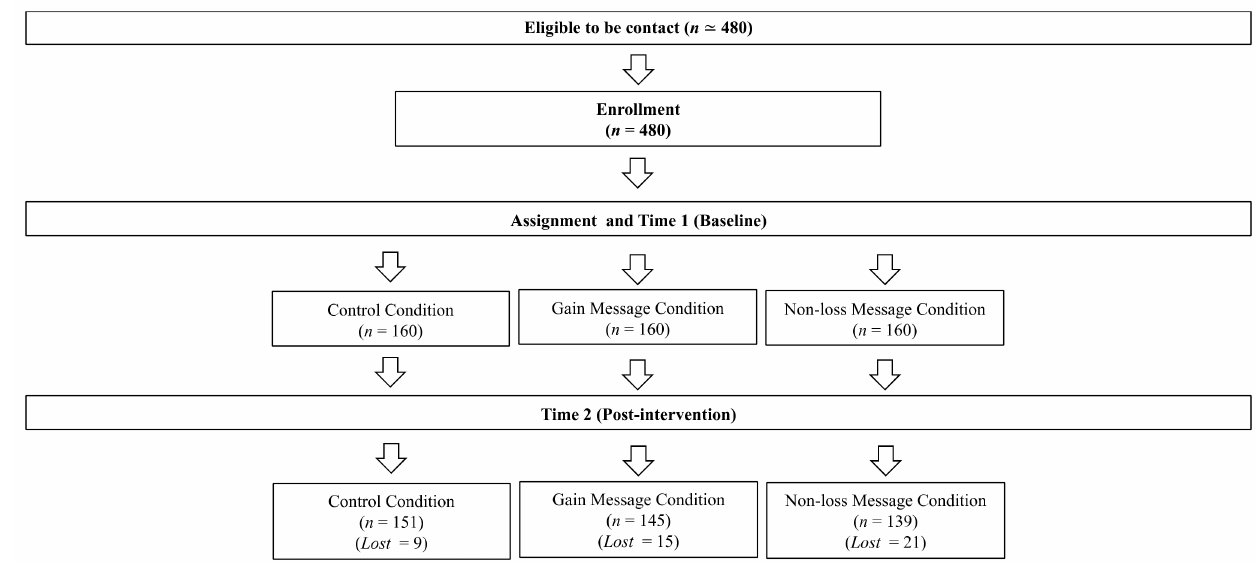
Figure 1. Flow chart of participants’